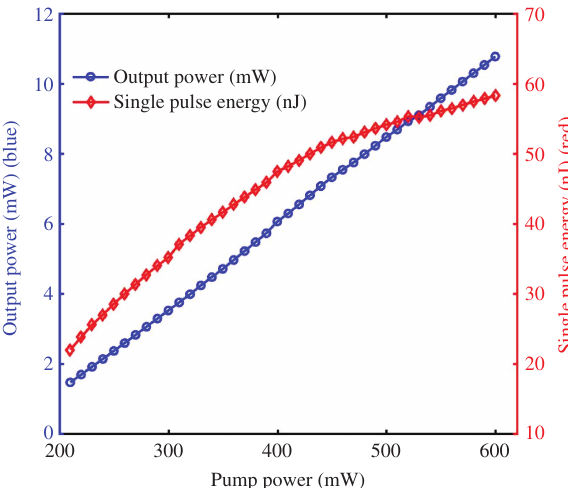
Figure 11: Output power and single-pulse energy vary with the increasing pump